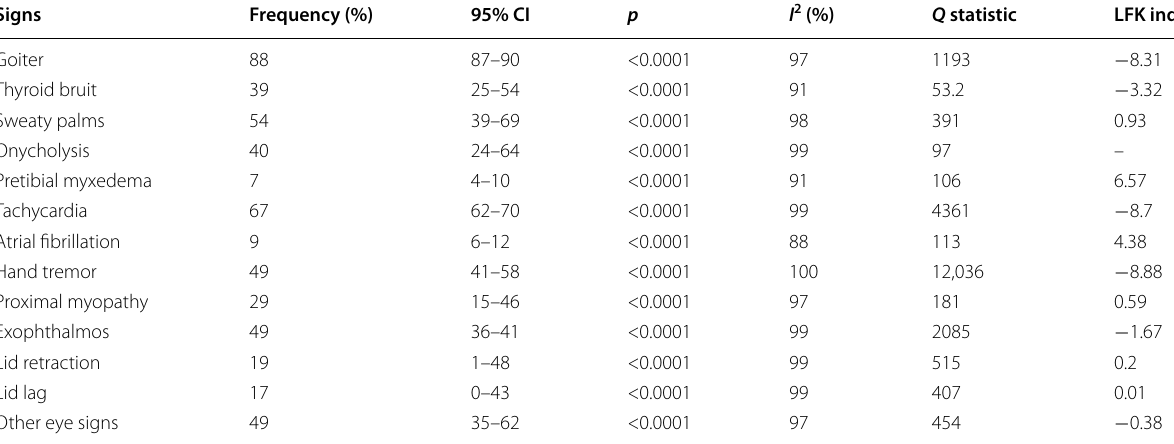
Table 11 The pooled frequencies of the signs of